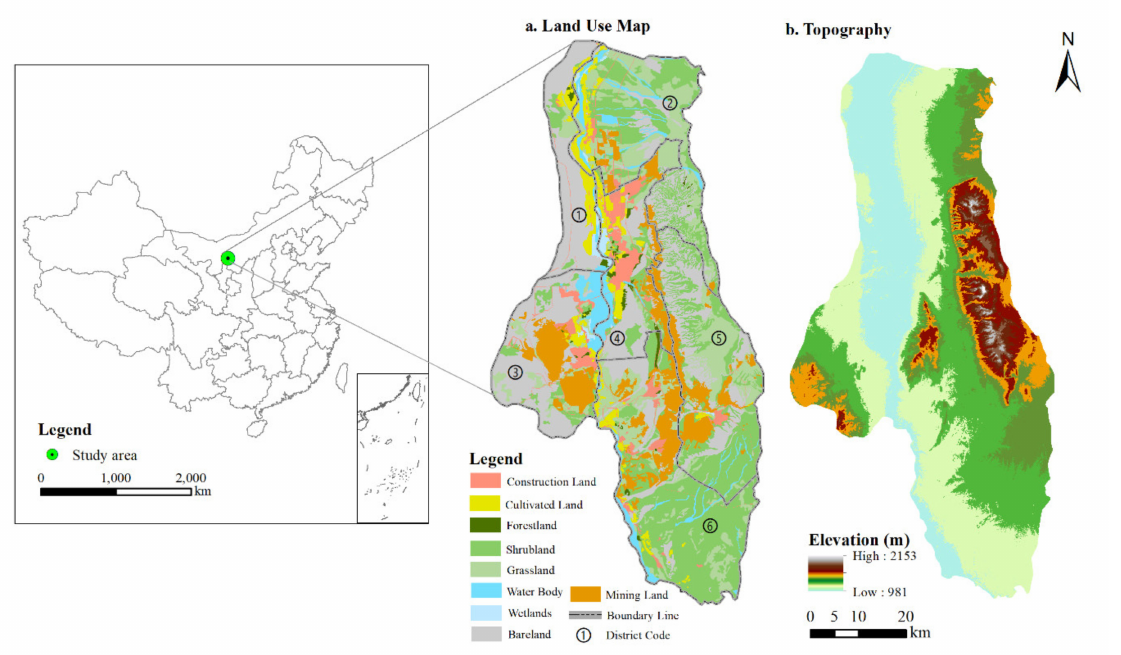
Figure 1. ( a – b ) Location, administrative divisions, land-use and land-cover map (a), and topography (b) of study area. Land-use and land-cover map was monitored at 2017, provided by the Institute of Geographic Sciences and Natural Resources Research in China. Note: districts of 1 (cid:79) , Uulan Buh; 2 (cid:79) , Mengxi; 3 (cid:79) , Wuda; 4 (cid:79) , Haibowan; 5 (cid:79) , Etuoke Banner; and 6 (cid:79) ,